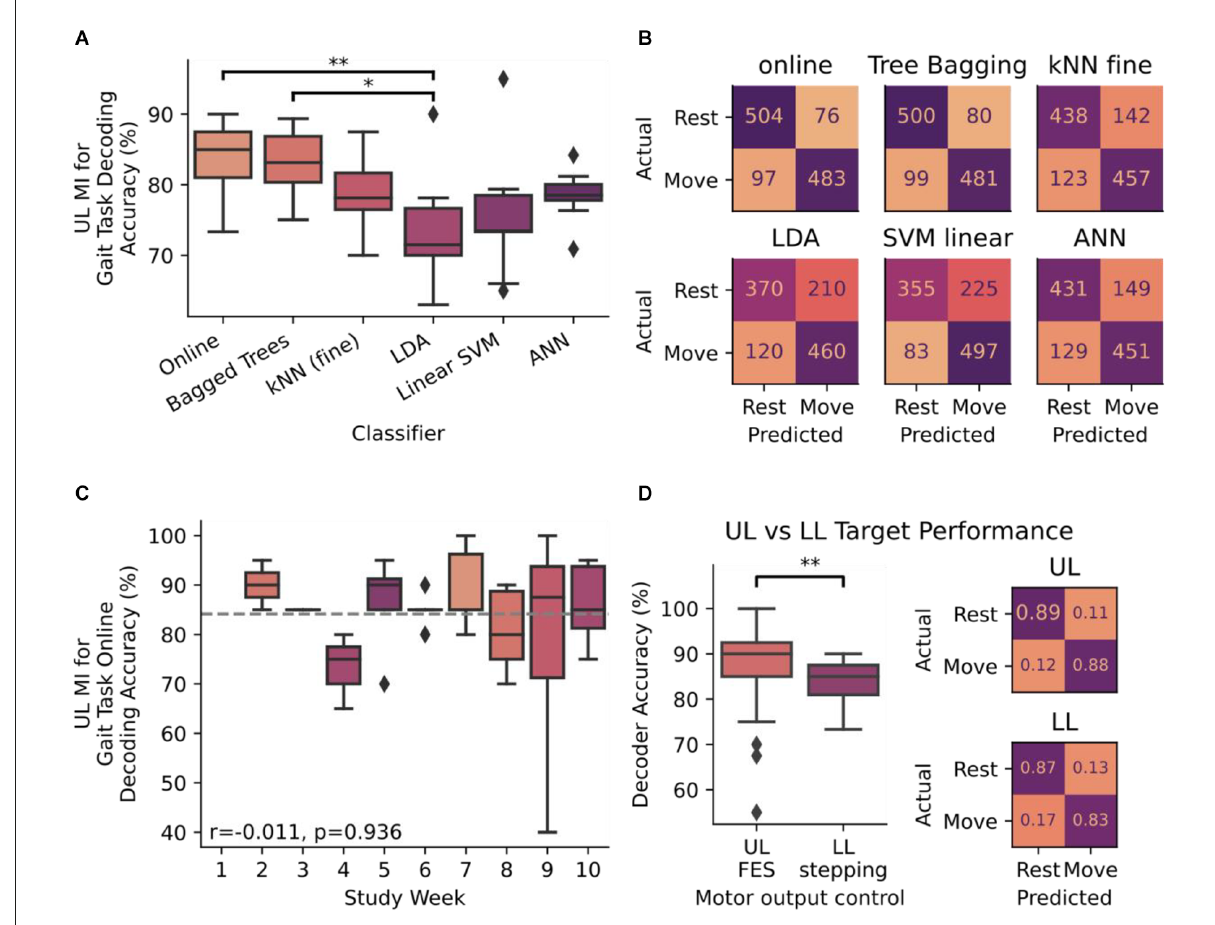
FIGURE3 (A) Decoder accuracy for decoding upper-limb (UL) motor-imagery (MI) for initiating stepping measured as a ratio of correctly decoded instructions to the total number of instructions presented. Accuracy was measured in six classifiers: online bagged trees, offline bagged trees, Fine K-Nearest Neighbors (kNN), Linear Discriminant Analysis (LDA), Linear Support Vector Machine (SVM), and an Artificial Neural Network (ANN). Differences between each classifier were detected by ANOVA and Tukey-HSD post hoc for pairwise analysis. (B) Confusion matrices for each of the six classifiers in panel (A) . Integer values range from 0 to 580, which is the number of times each motor imagery instruction presented to the subject over the 9 weeks of close-loop analysis in the study. (C) Accuracy performance of online bagged trees classifier over the course of the 10 week study period. Gray dotted line indicates the mean value across all weeks (84.15%). The stability of the decoder was measured with accuracy with respect to time and evaluated using Spearman’s correlation coefficient (r). (D) Differences in decoder performance, measured